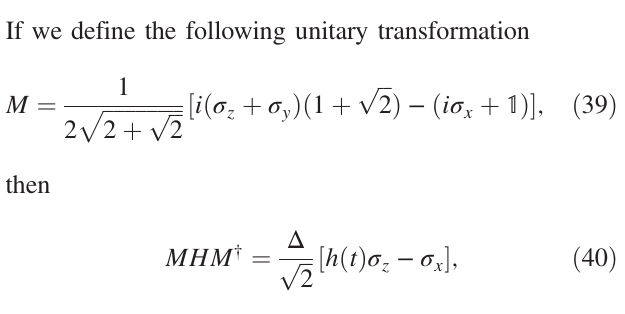
FIG. 4. Schematic of the braiding process at a T junction. Each dot represents a MZM, and the lines connecting dots indicate which MZMs are in a definite fusion channel at a given time. This sequence of states can be obtained as the ground states of a Hamiltonian with nonzero coupling between the pair connected by a line at each step and by adiabatically tuning the Hamiltonian from one step to the next. This sequence effectively braids the MZMs labeled by red and blue